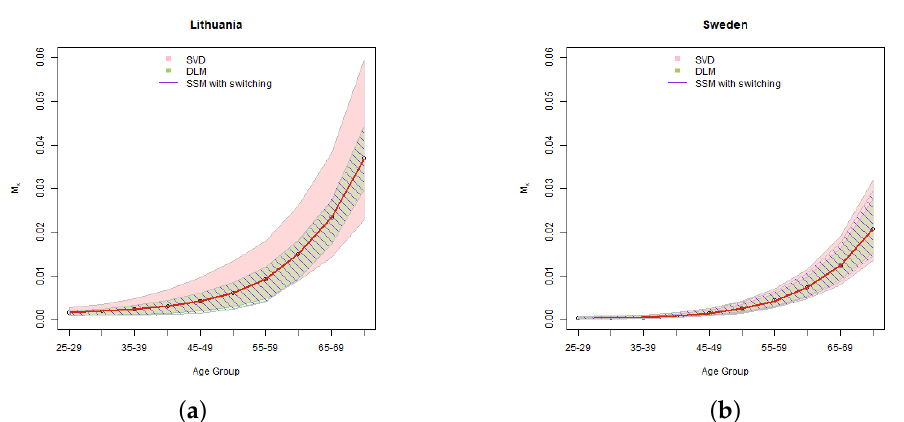
Figure 7. Results of simulation of 15 year projection of mortality rates for ages from 25 to 74 for Lithuania ( a ) and Sweden ( b ). The shaded region provides 95% simulated confidence intervals of the projected mortality rates fitted using SVD, DLM and SSM with switching.